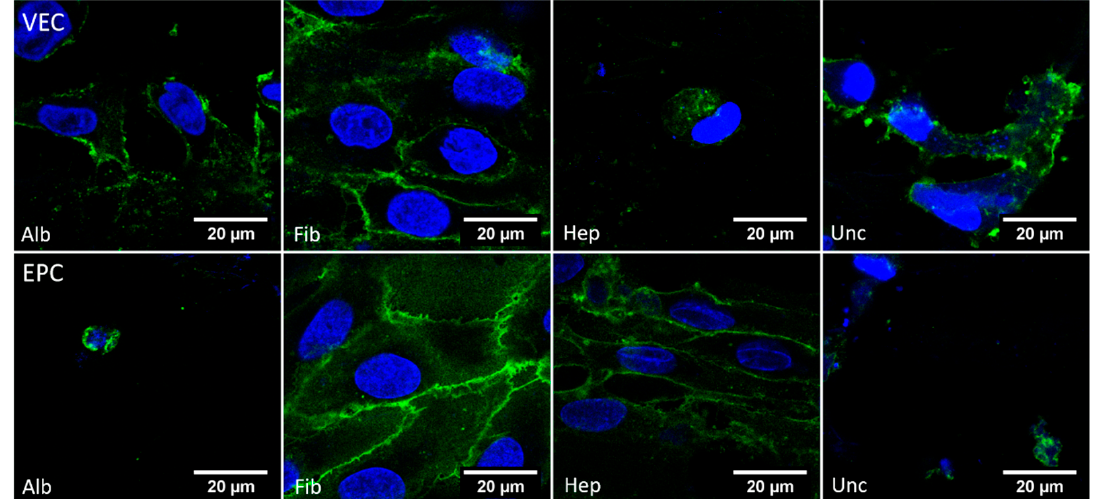
Figure 8. Confocal microscopy images of BNC grafts seeded with vascular endothelial cells cultivated under dynamic conditions and stained against DAPI (blue) and CD31 (green). A distinct signal of CD31 on VECs was only seen clearly in the fibronectin group, and for EPCs in the fibronectin and heparin groups.